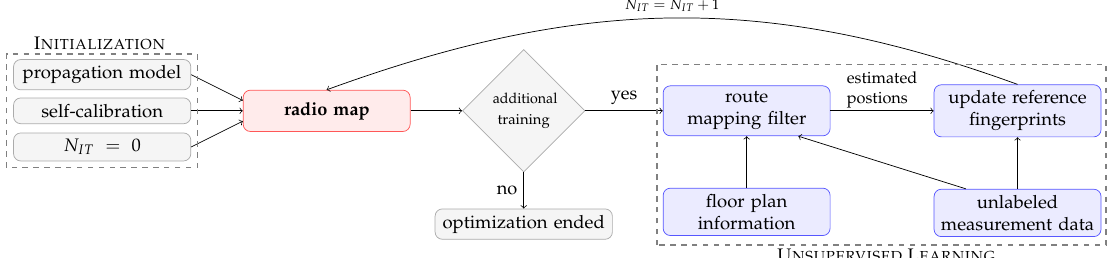
Figure 1. Flow graph of the proposed technique to construct and optimize a model-based radio map. N IT is the current training iteration.